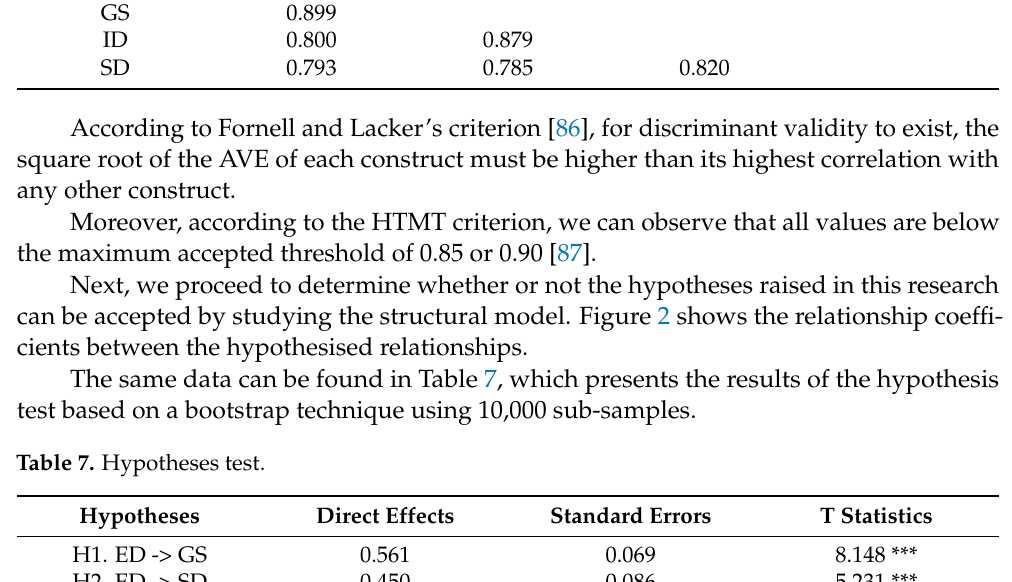
Table 6. Discriminant validity assessment by the heterotrait–monotrait ratio (HTMT). ED GS ID SD ED